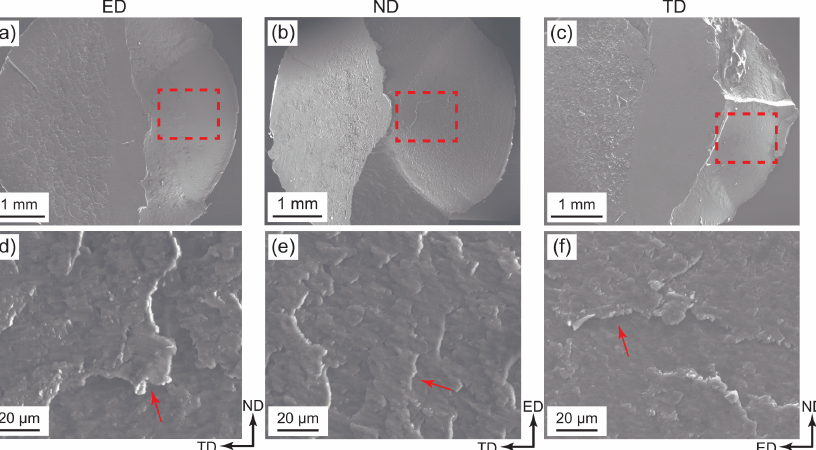
Figure 5. SEM fractographs of the postmortem specimens for dynamic compression at 5.9 × 10 3 s − 1 along ( a ) ED, ( b ) ND and ( c ) TD. ( d – f ) are magnified views of the regions indicated by the rectangles in ( a – c ), respectively. The scaly features are pointed out by red arrows.